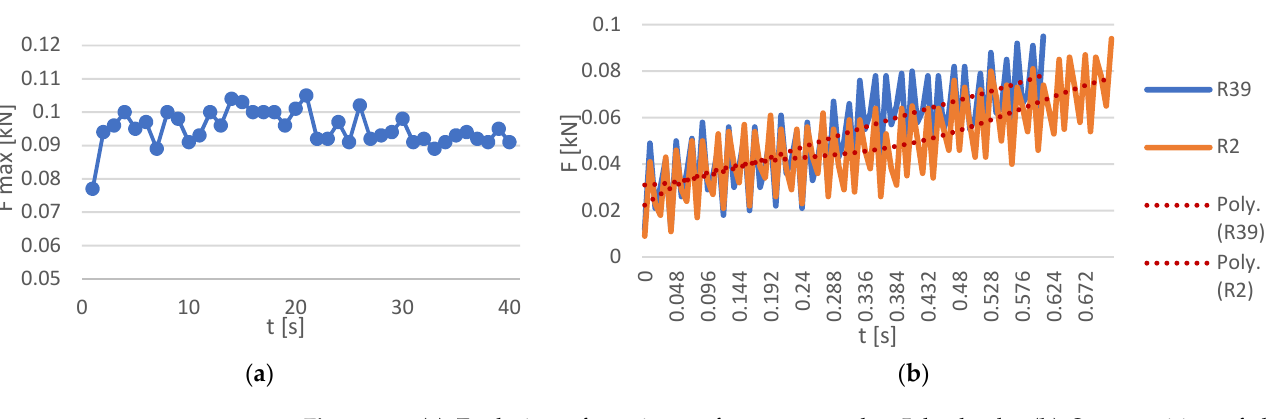
Figure 8. ( a ) Evolution of maximum forces per cycle—5 kg load. ( b ) Superposition of the forces’ evolution at initial and final repetition—5 kg